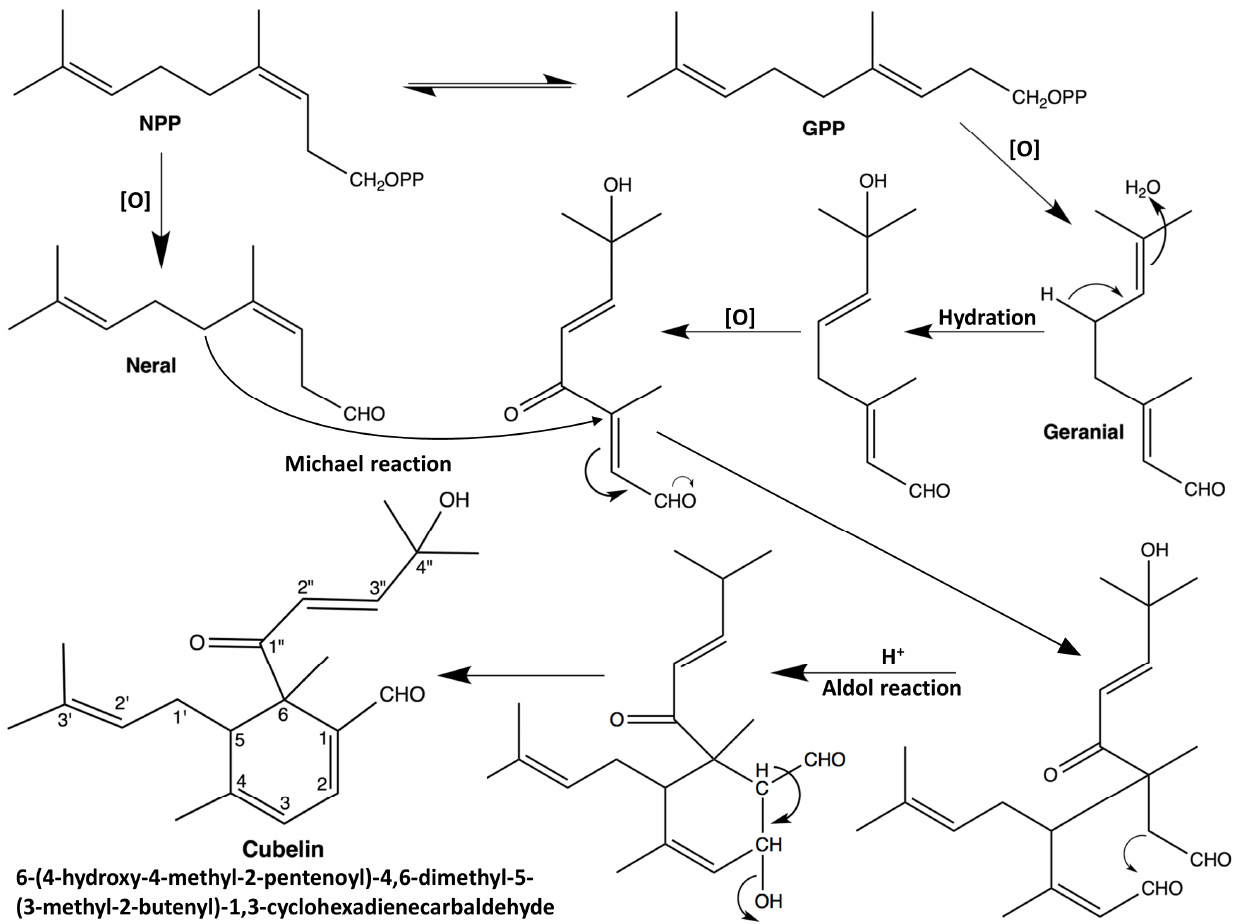
Figure 3. Proposed biosynthesis pathway of cubelin. The numeration in cubelin structure was assigned based on the rule of IUPAC